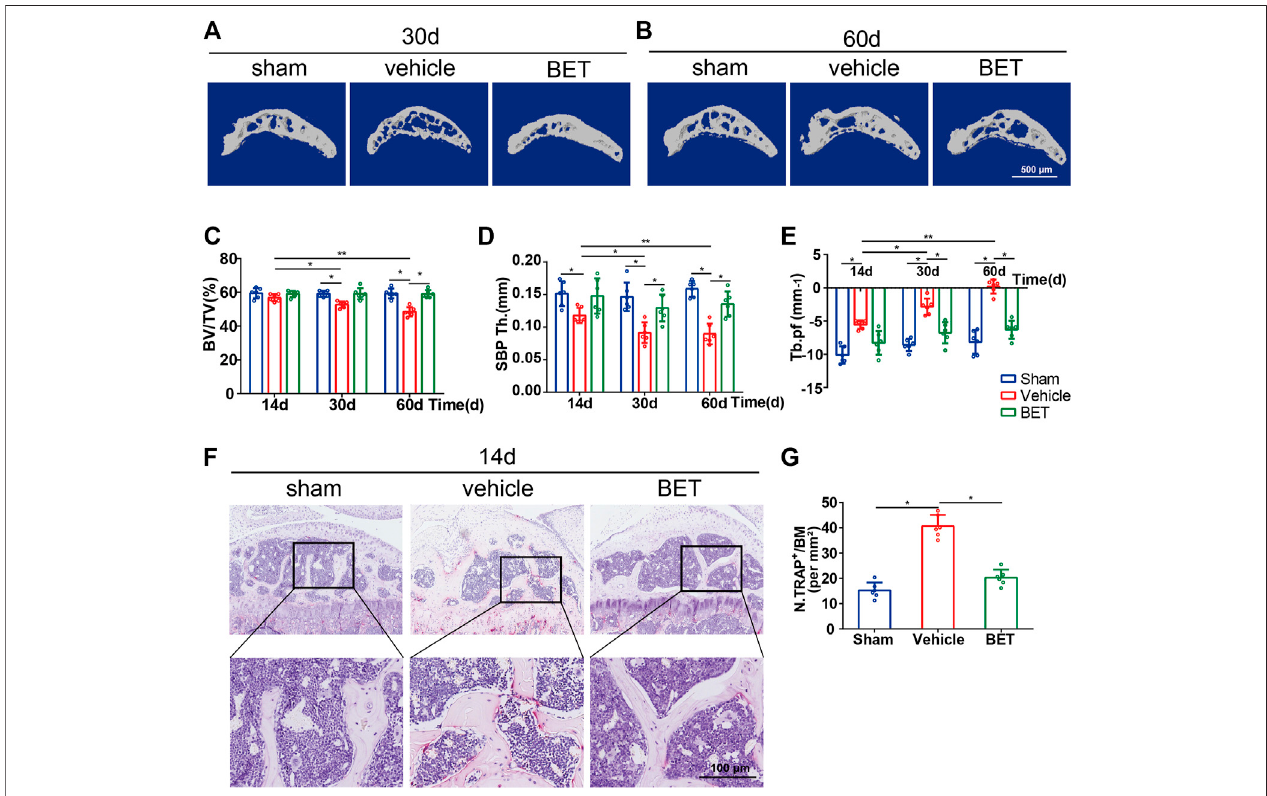
FIGURE 4 | Betaine maintains subchondral bone microarchitecture in ACLT mice. (A,B) Sagittal 3D micro-CT images of subchondral bone medial compartment 30- and 60-days post operation. Scale bar, 500 μ m. (C – E) Quantitative analysis of bone volume/tissue volume (BV/TV) of tibial subchondral bone, subchondral bone plate thickness and trabecular pattern factor (Tb.pf). (F) TRAP staining in subchondral bone 14 days after operation. Scale bar, 100 μ m. (G) Quanti fi cation analysis of TRAP staining in subchondral bone 14 days after operation. * p < 0.05 as denoted by bar, ** p < 0.01 as denoted by bar.